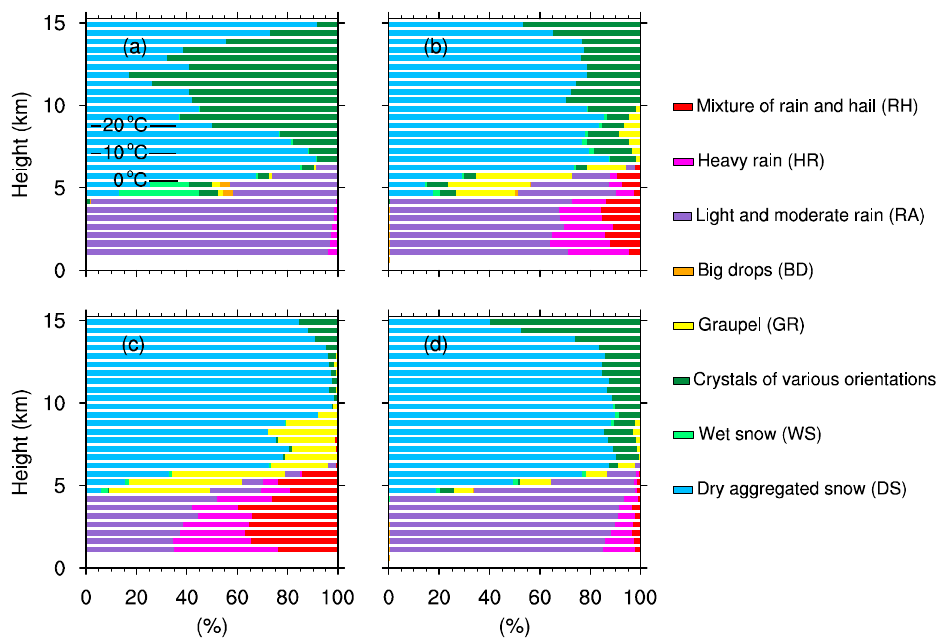
Figure 9. Vertical distribution of the probability of various hydrometeor types over Jinjiang esti- mated using the HCA (%) during the four stages: ( a ) initial (S1), ( b ) developing (S2), ( c ) mature (S3), and ( d ) dissipating (S4). The level of 0 ◦ C, − 10 ◦ C, and − 20 ◦ C are labeled from bottom to top, respec- tively.